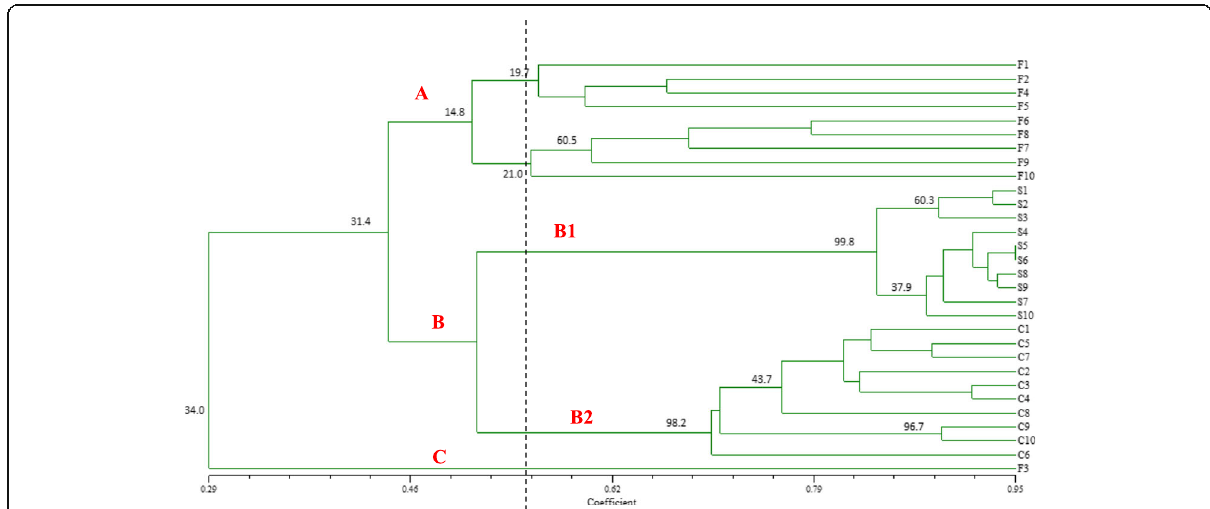
Fig. 6 UPGMA dendrogram of cluster analysis of RAPD markers showing the genetic relatedness among the growth forms of Dendrocalamus strictus . Fork number indicates the percentage of times the cluster occurred in a bootstrap analysis. F1 – F10 = FRI campus, S1 – S10 = Shivpuri range and C1 – C10 = Chiriapur range